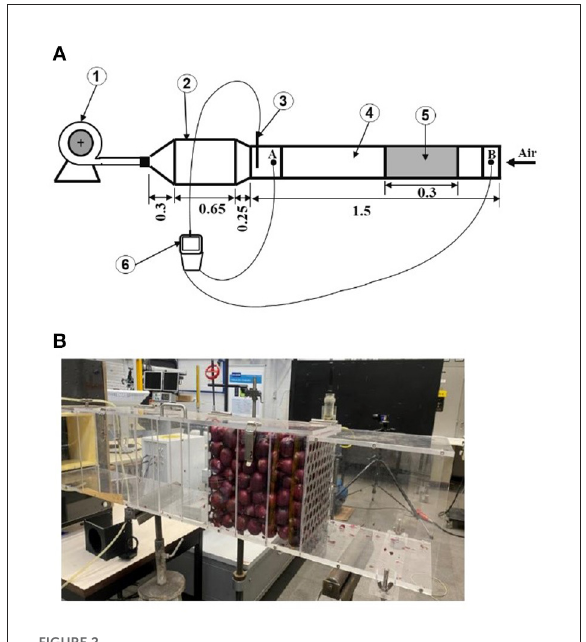
FIGURE2 (A) Schematic representation of the experimental setup for pressure drop measurements: (1) centrifugal fan, (2) wind tunnel conditioning unit, (3) airflow speed measurement, (4) measurement section, and (5) data logger. A and B are pressure taps (dimensions in m). (B) The testing chamber of 0.3m in length and is filled with a bulk of onion bulbs.